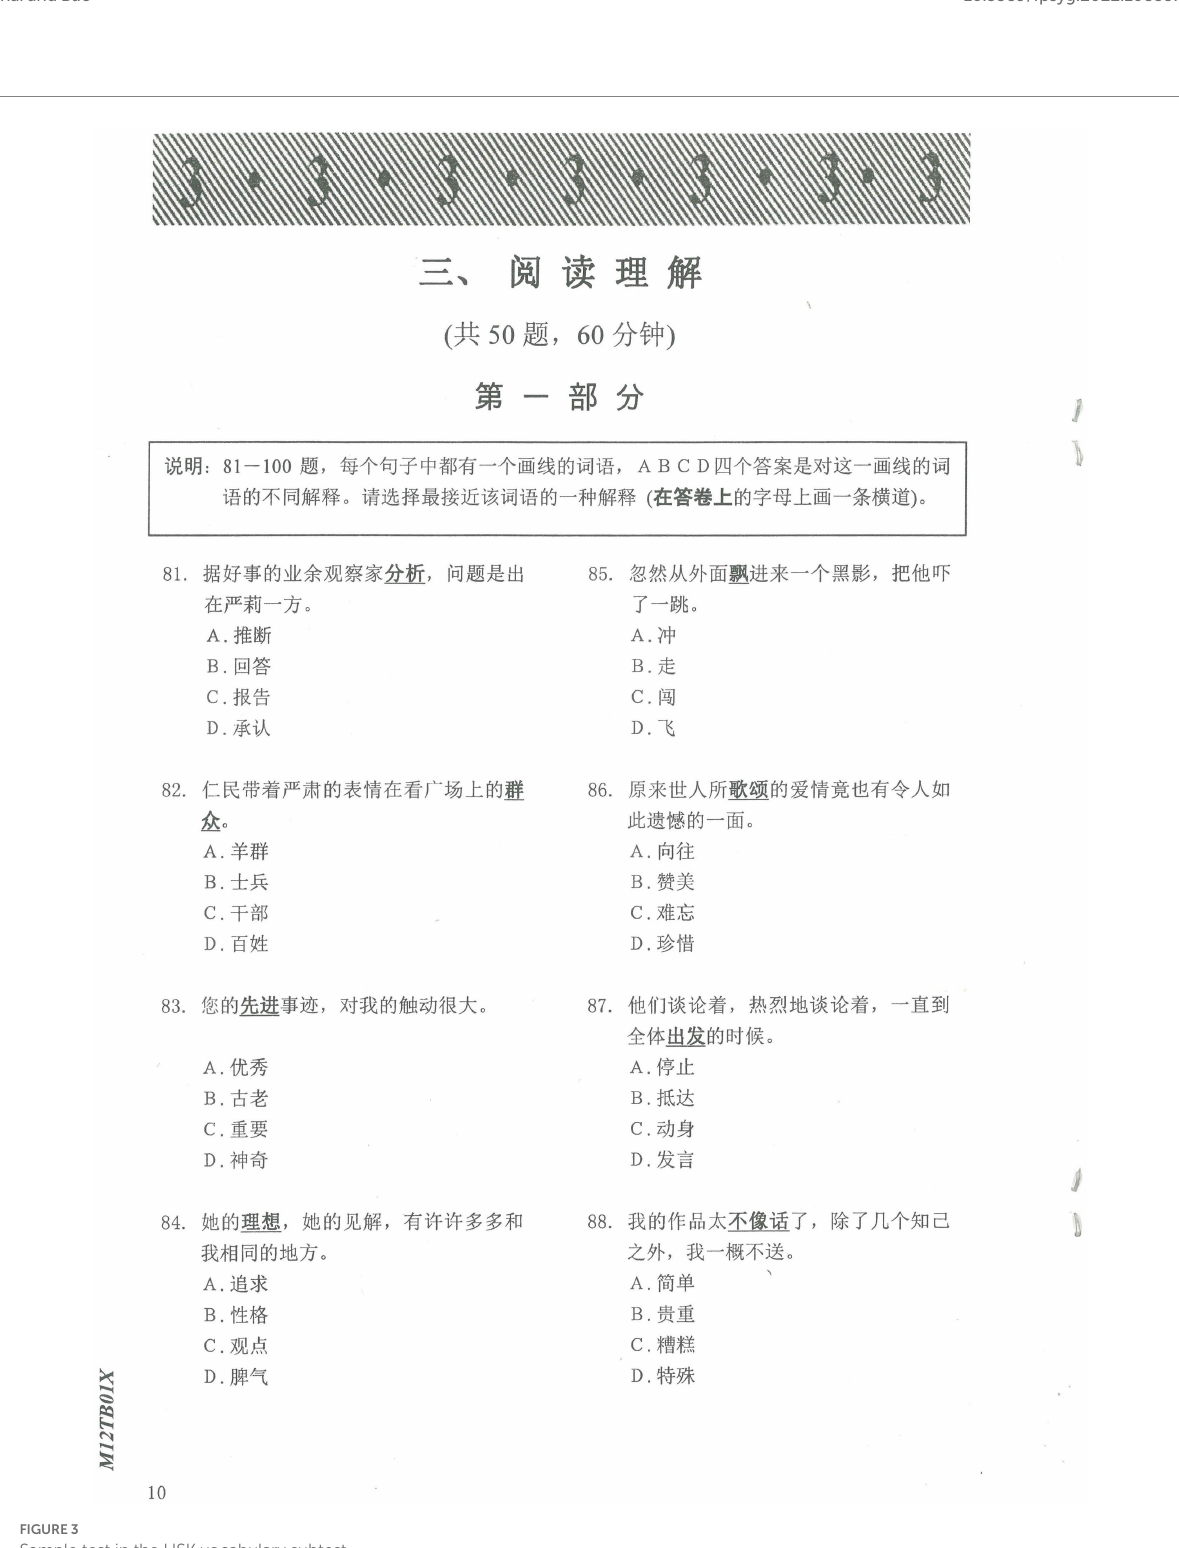
FIGURE 3 Sample test in the HSK vocabulary